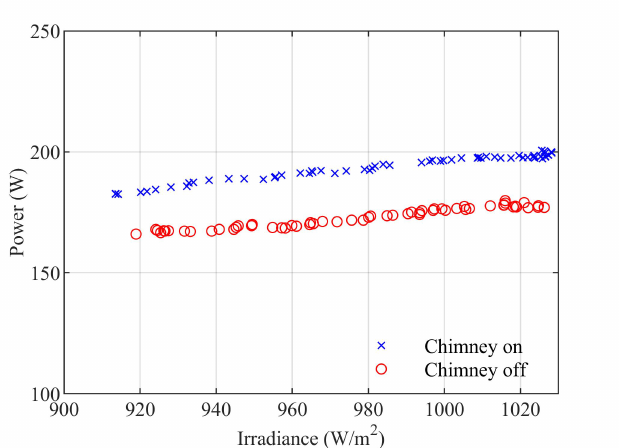
Figure 12. Maximum power available for different irradiance levels with the chimney activated and